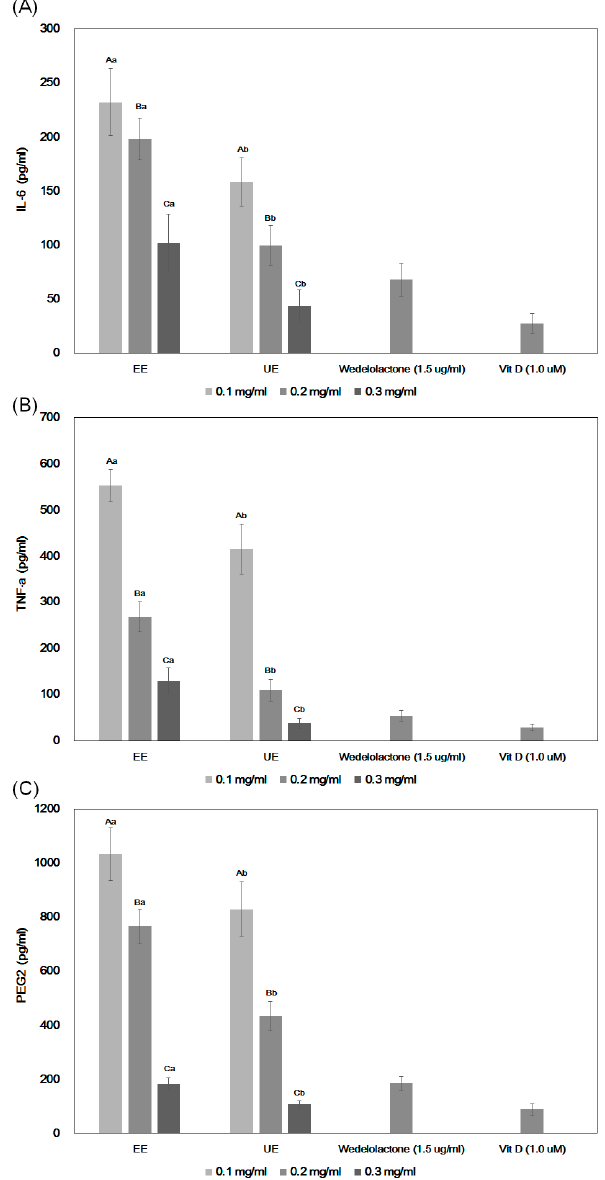
Figure 4. Comparison of ( A ) interleukin-6 (IL-6), ( B ) tumor necrosis factor- α (TNF- α ), and ( C ) prostaglandin E 2 (PGE 2 ) production in treating three different concentrations of the E. prostrata L. extracts along with 1.0 μ M of vitamin D 3 and 1.5 μ g/mL of wedelolactone as positive controls. Mean values ± SD from triplicate separated experiments are shown. Means with different letters (A–B) within the same sample are significantly different at p < 0.05, and means with different letters (a–b) within the same concentration are significantly different at p < 0.05. (1) EE: 70% ethanol extraction at 80 °C, ( 2) UE: ultrasonic extraction with 70% ethanol at 40 °C.